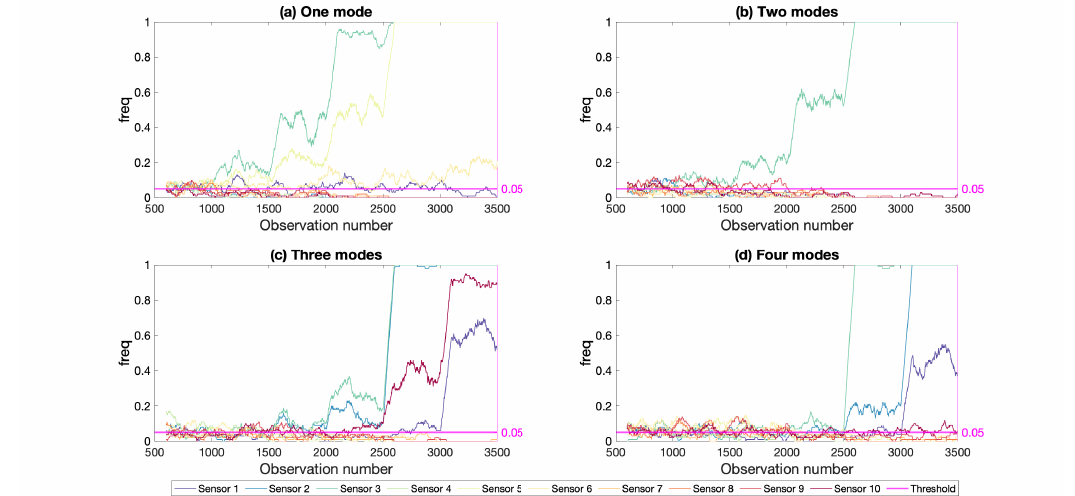
Figure 15. Effect of number of modes; damage at the mid-span; 5% noise.